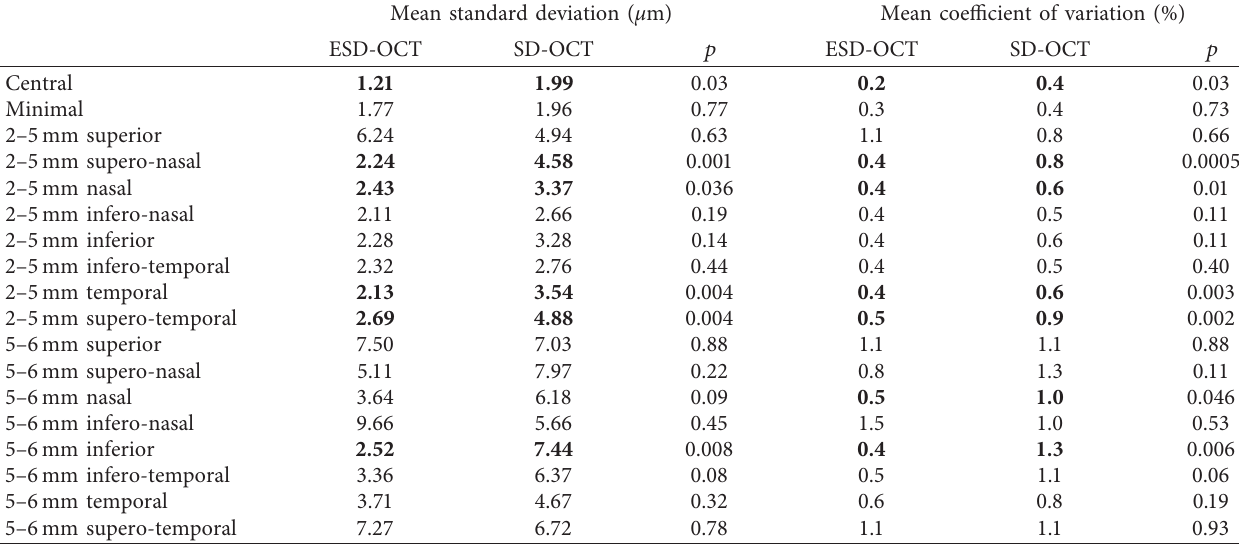
Table 2: Interobserver reproducibility of corneal thickness assessment with Enhanced Spectral-Domain and Spectral-Domain-Optical Coherence Tomography in normal